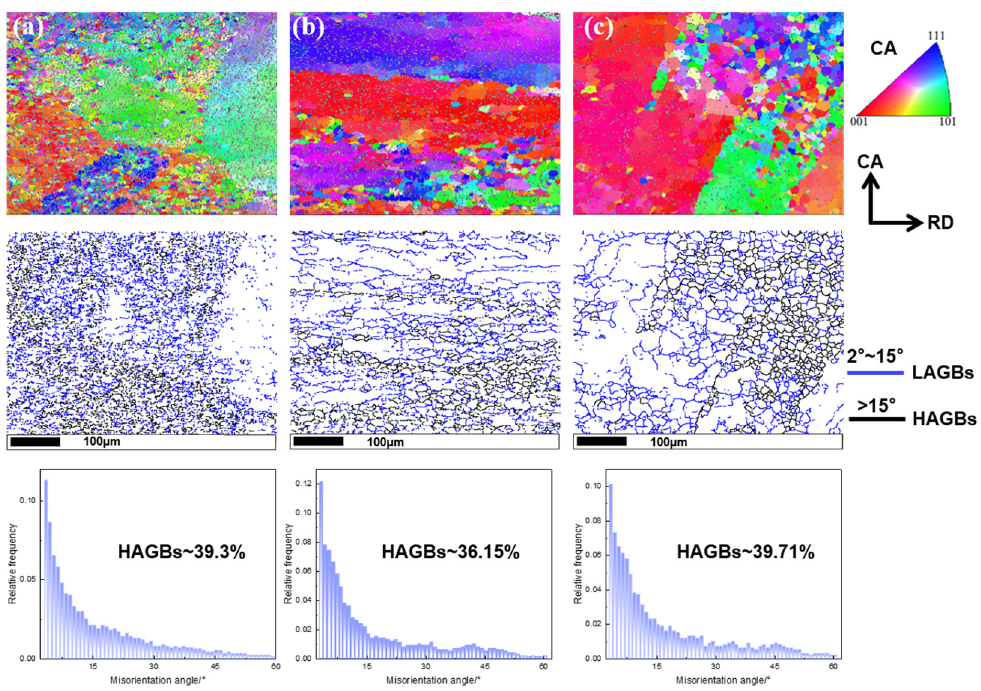
Figure 10. Distribution of the grain boundary misorientation in the β phase for the deformed micro- structure and the corresponding IPF maps at different deformation conditions: ( a ) 740 °C/0.0001 s − 1 ; ( b ) 760 °C/0.0001 s − 1 ; ( c ) 780 °C/0.0001 s − 1 .